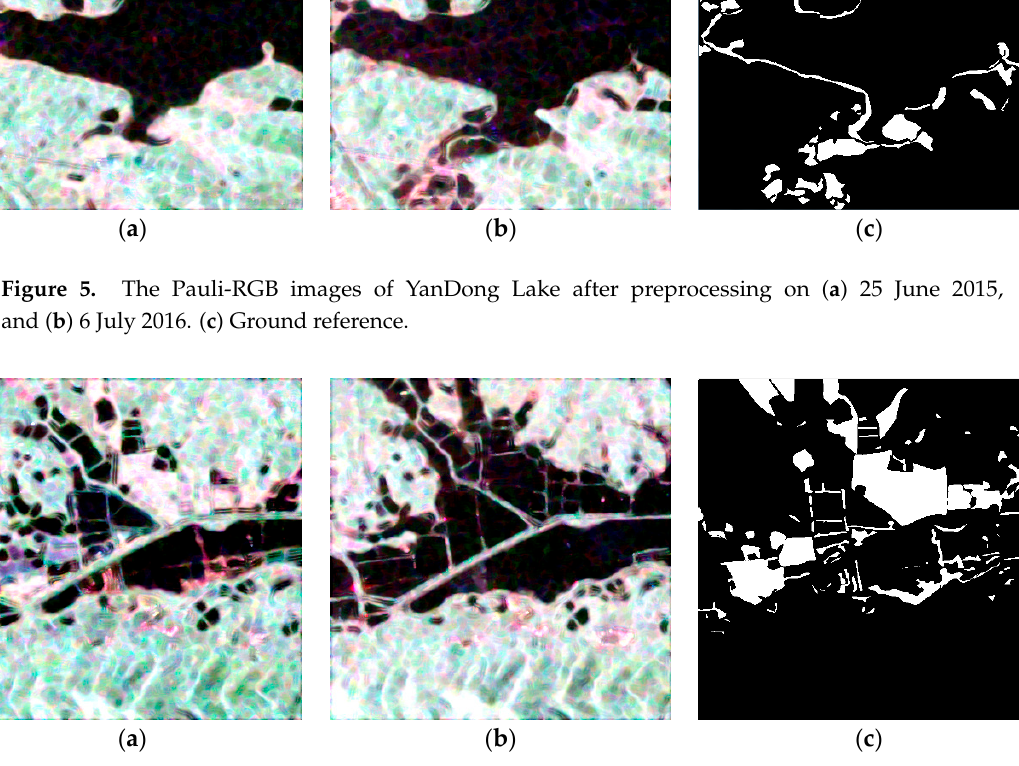
Figure 6. The Pauli-RGB images of Liangzi Lake after preprocessing on ( a ) 25 June 2015; and ( b ) 6 July The Pauli-RGB images of Liangzi Lake after preprocessing on ( a ) 25 June 2015, 2016. ( c ) Ground reference. and ( b ) 6 July 2016. ( c ) Ground